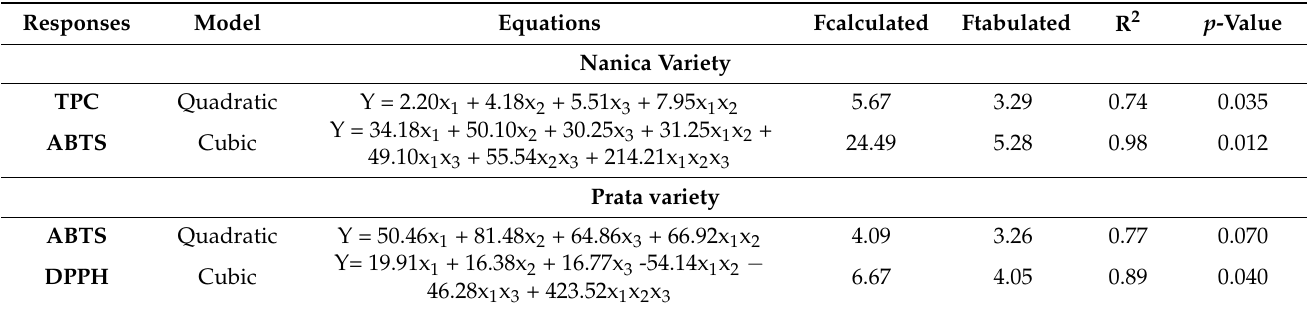
Table 3. Analysis of variance (ANOVA), including models, R 2 and probability values for the final reduced models for TPC and antioxidant activity (ABTS and DPPH) from banana bract extracts (Nanica and Prata varieties).